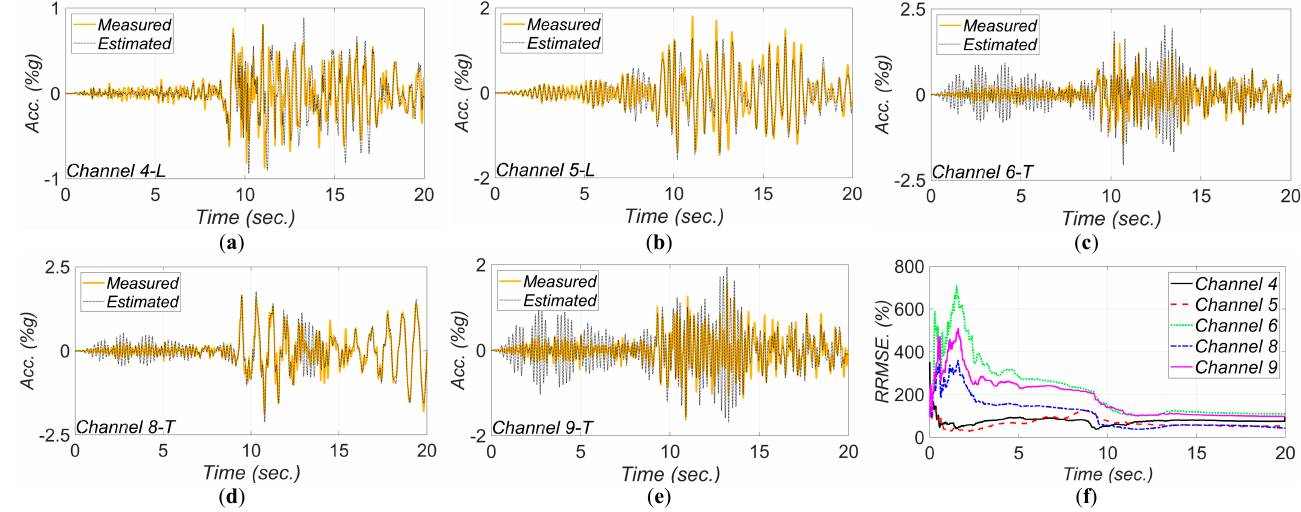
Figure 21. Comparison between measured and estimated (from updated model) responses at different measurement channels for 2018 Santa Cruz earthquake: ( a ) channel 4, ( b ) channel 5, ( c ) channel 6, ( d ) channel 8, ( e ) channel 9. Part ( f ) is the corresponding RRMSEs.